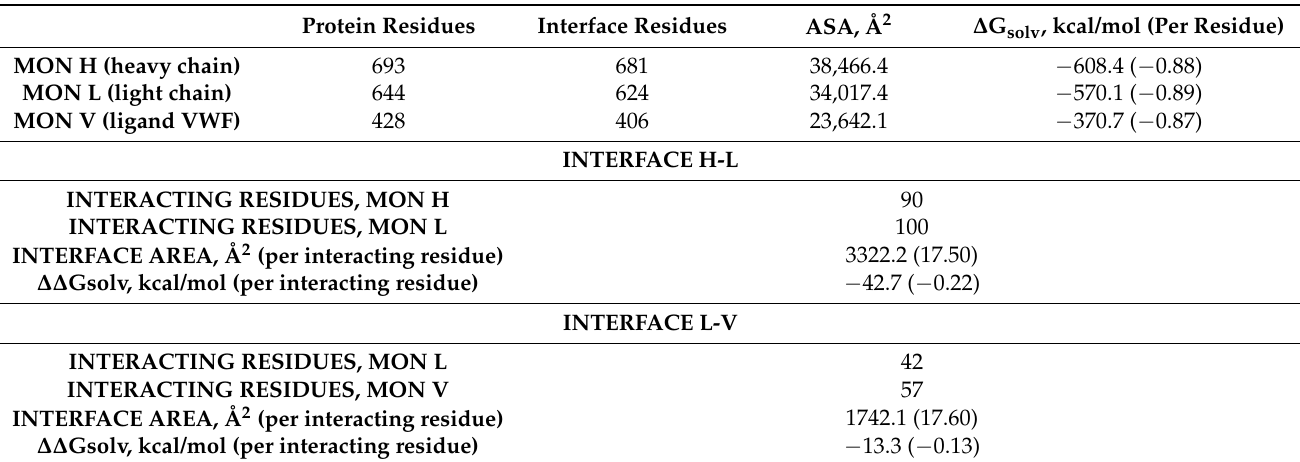
Table 3. PISA results for the VWF/BDD-FVIII complex. Values within brackets refer to the value specific per residue. Accessible surface area (ASA) of interface (Å 2